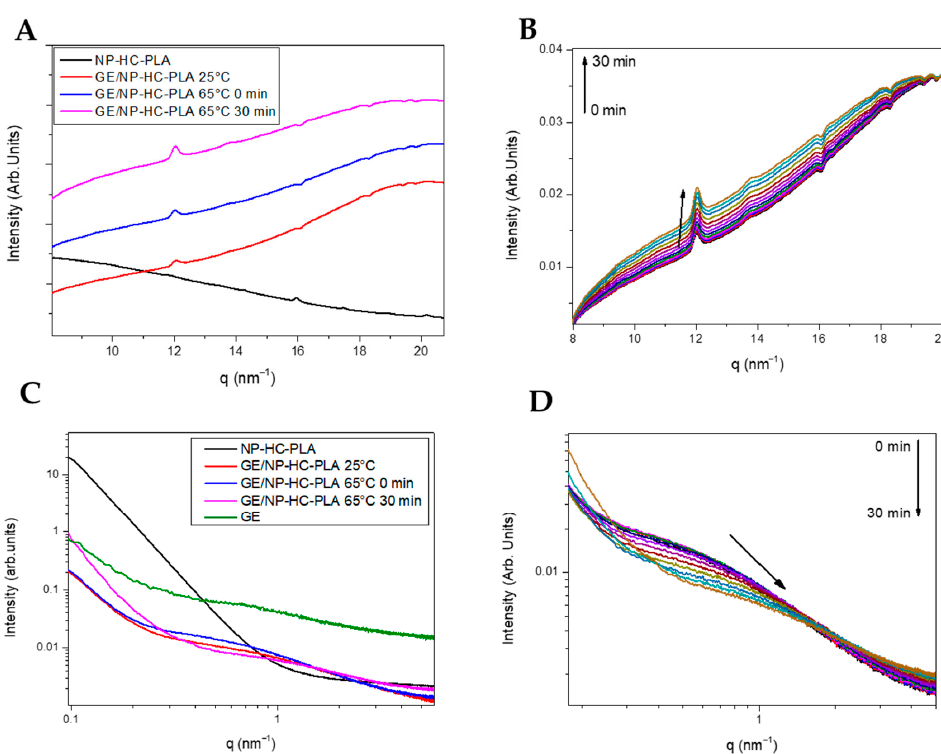
Figure 6. ( A ) WAXS pattern of NP-HC-PLA (black line), the bionanocomposite of NP-HC-PLA at room temperature (red line), 65 °C (blue line) and after 30 minutes at 65 °C (pink line). ( B ) WAXS pattern evolution during the isothermal at 65 °C. ( C ) SAXS pattern of NP-HC-PLA (black line), the bionanocomposite of NP-HC-PLA at room temperature (red line), 65 °C (blue line) and after 30 minutes at 65 °C (pink line). ( D ) SAXS pattern evolution during the isothermal at 65 °C. The extended rheological properties of DOX-loaded bionanocomposites (GE/NP- PLA/DOX) were examined to assess in detail their mechanical performance by evaluating their critical deformation and storage capability. The stability of the bionanocomposites in the linear viscoelastic region (LVR) was probed by subjecting the GE/NP-PLA/DOX to strain sweeps at 20 °C, in which the strain amplitude ranged from 0.1 to 1000% at a con- stant temperature and a frequency of 10 rad·s − 1 (Figure 7A). The strain sweeps were con- ducted to determine the region where the viscoelastic behavior of the gelatin network is independent of the applied strain. Likewise, the strain sweeps of the GE/NP-PLA/DOX have shown that the viscoelasticity remains fairly linear up to a strain greater than 100% (Figure 7A) and with higher values for the GE/NP-PLA/DOX compared to the hydrogel of gelatin, which proves the enhanced mechanical stability of the GE/NP-PLA/DOX. In addition, frequency sweeps of the GE/NP-PLA/DOX were performed to understand the viscoelastic behavior as a function of the relaxation time scale to allow the prediction of the storage properties and process conditions during the application of the materials (Fig- ure 7B). The elastic modulus component prevailed over the viscous in the entire region (G ′ > G ″ ) under study [27], confirming its mechanical stability. The flow behavior of GE/NP-PLA/DOX indicates the formation of an increase in the elastic network, which is characteristic of complex gels that approach a solid-like trend. Both moduli increased with angular frequency, showing similar storage and loss modulus values between the studied gelatin networks, with GE/NP-Rac-PLA/DOX being the highest, followed by GE/NP-SC- PLA/DOX, indicating the greater stability of the gel.